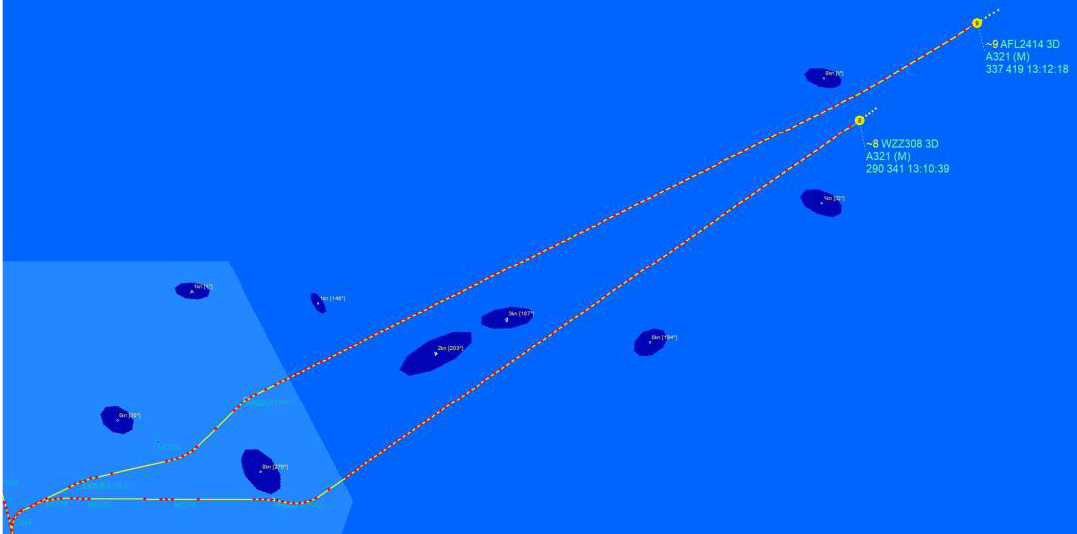
Figure 21. Two different route calculations for aircraft approaching Malpensa from the northeast through a loose group of convective areas. Even a small variance in temporally different initial conditions can lead to different optimal routing. Malpensa traffic mix from 11 May 2019 with weather from 6 August 2019 and the RaNDeVIL nowcast model.